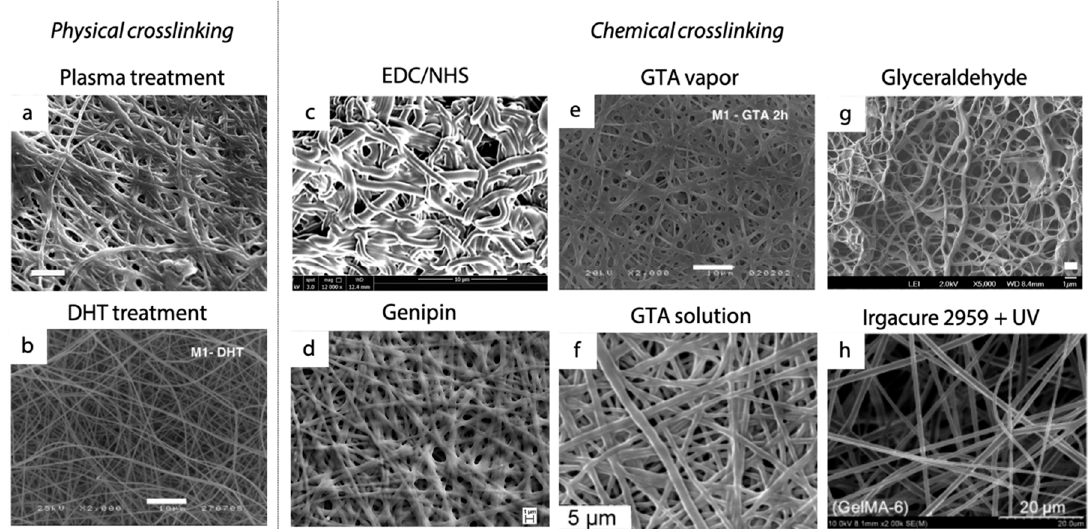
Figure 4. Morphology of electrospun gelatin nanofibers cross-linked with different strategies: ( a )